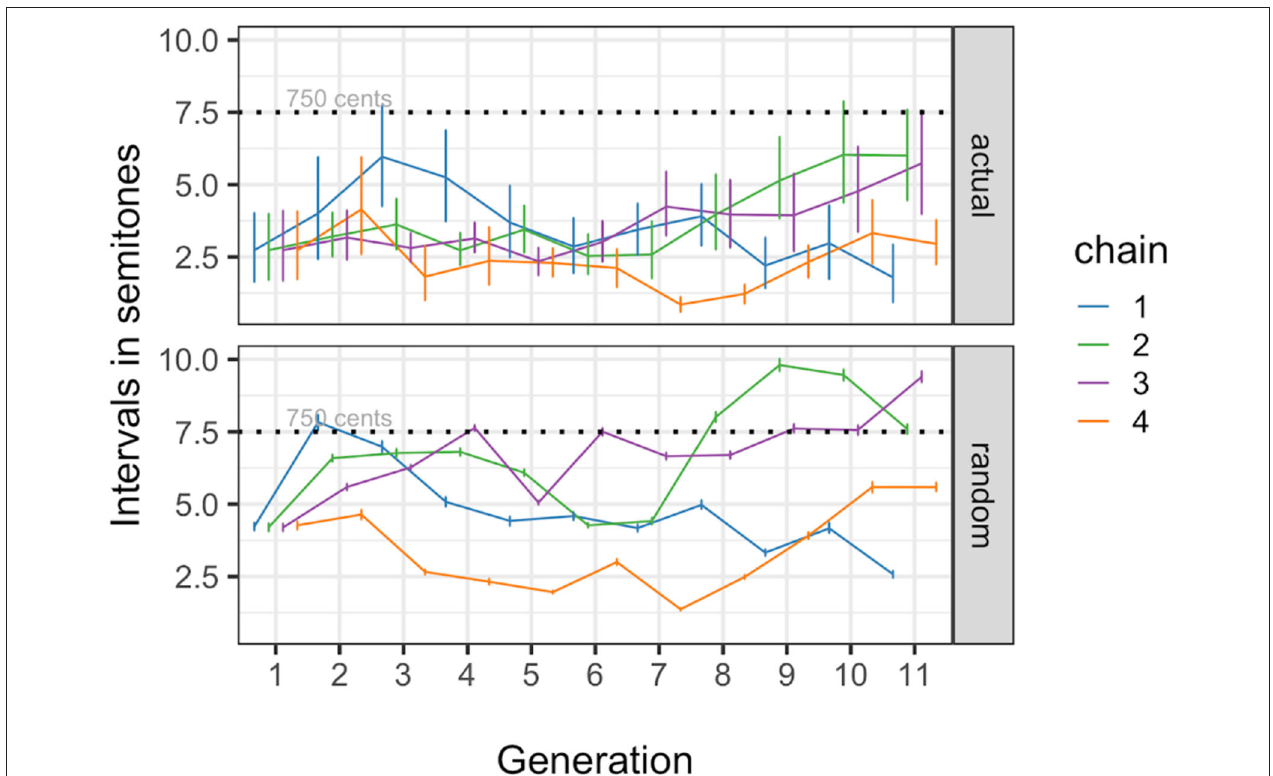
FIGURE 9 | Mean absolute onset-to-onset differences across chains and generations for the actual data (top panel), as well as means for the intervals measured in 100 randomly shuffled whistles (bottom panel). The dashed line indicates the 750 cent level.